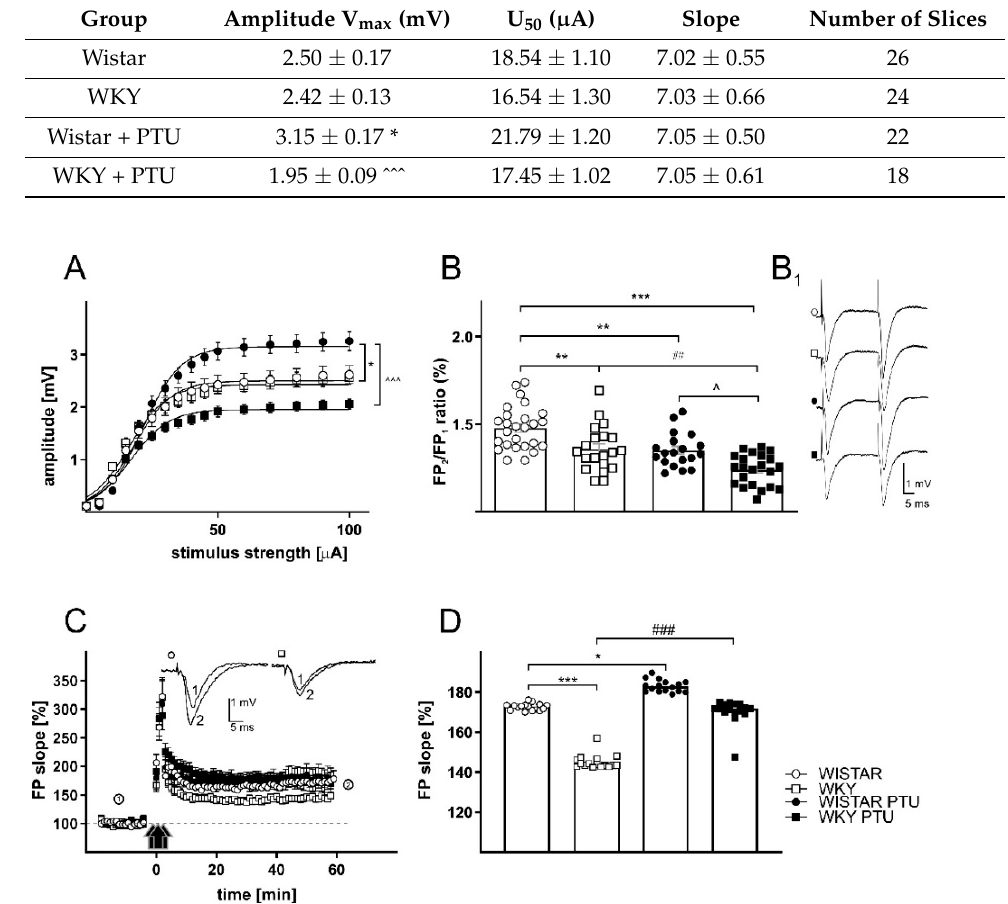
Table 1. Input-output relationship plots in the CA1 region of the hippocampus. The results are expressed as the mean ± SEM. * p < 0.05 vs. the control group (Wistar rats); ^^^ p < 0.001 vs. Wistar PTU group. WKY, Wistar–Kyoto.